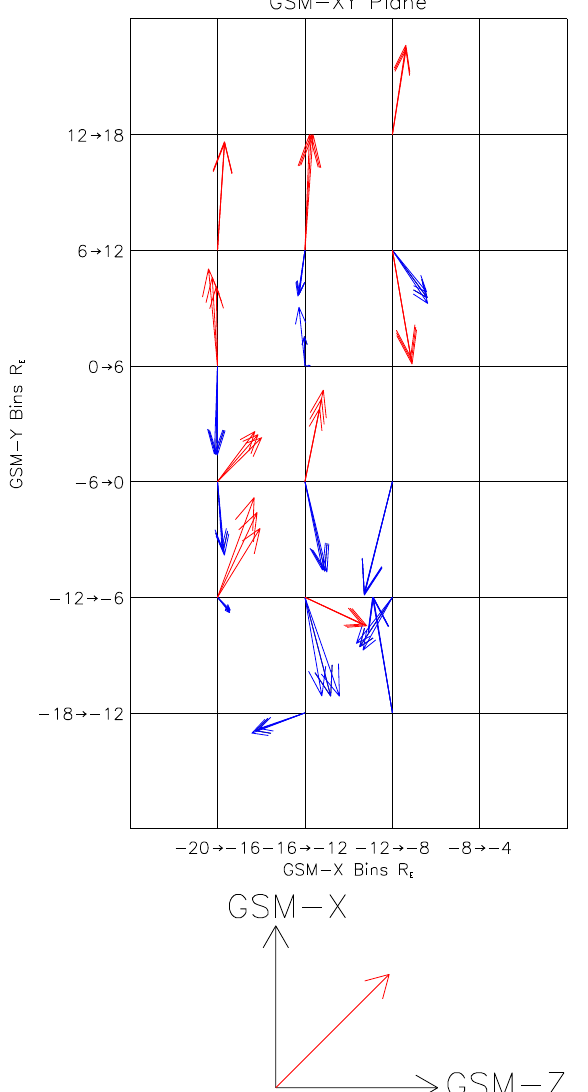
Fig. 11. The projection of the average unit normal of the boundary between the thinning plasma sheet and the lobe in the GSM–ZX direction is shown as a function of position in the GSM–YX plane for the north lobe (blue vectors) and south lobe (red vectors). Error bars, calculated from the extreme errors on the individual vectors, are plotted when more than one normal vector was used for the averaging.